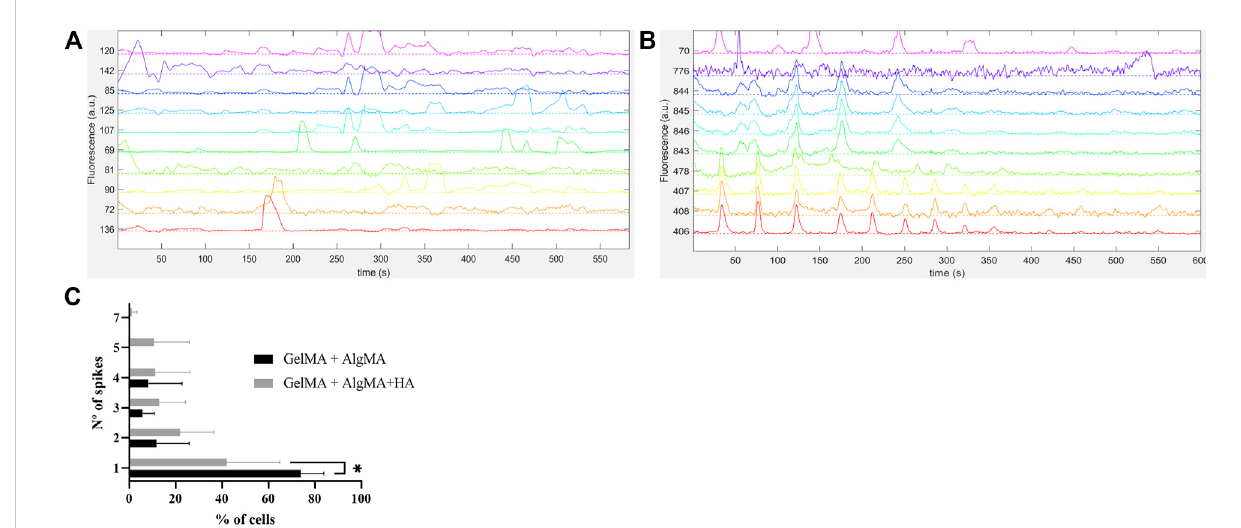
FIGURE 9 Functional assessment of the cells embedded in the biomaterials via calcium imaging with Fluo4AM (A) Traces of spontaneous activity of the cells embeddedinGelMA+AlgMAhydrogelonday15ofculture; (B) tracesofspontaneousactivityofthecellsembeddedinGelMA+AlgMA+HAhydrogelon day15 of culture; (C) quanti fi cation ofthe number ofspontaneous spikes of active cells in bothhydrogels during 10 min of recording. Data are presented as mean ± standard deviation. Statistical signi fi cance was calculated using a two-way variance analysis (ANOVA) with Sídák ’ s post hoc multiple comparisons test considering * p <